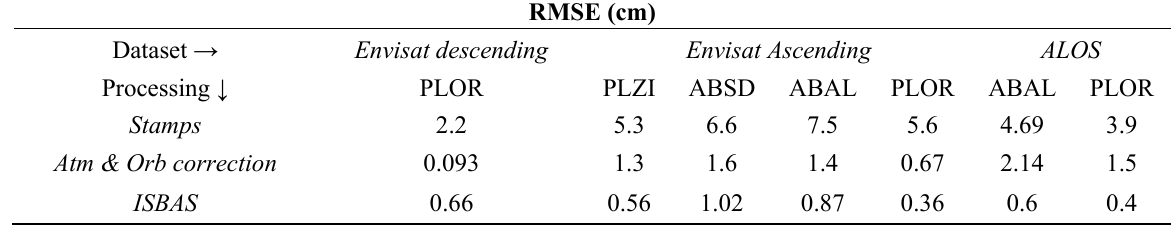
Table. 1. Root mean square error (RMSE) values between GPS and InSAR results.